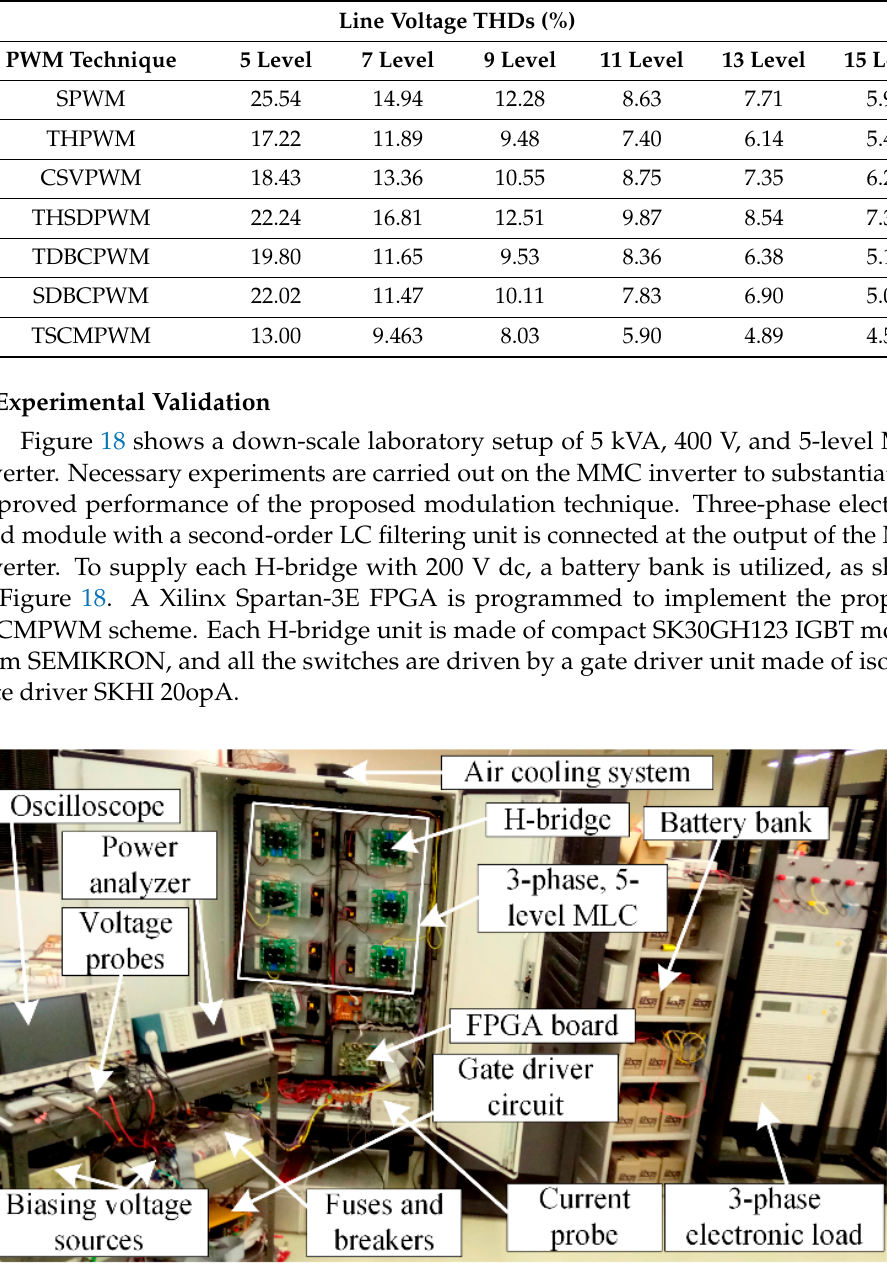
Figure 18. Photograph of the experimental setup. Figure 19a shows the TSCMPWM reference modulating waveforms. The IGBT mod- ules are operated with 1.2 kHz switching frequency. Figure 19b,c show the three-phase line–line PWM voltages before filter and three-phase line currents after filter,